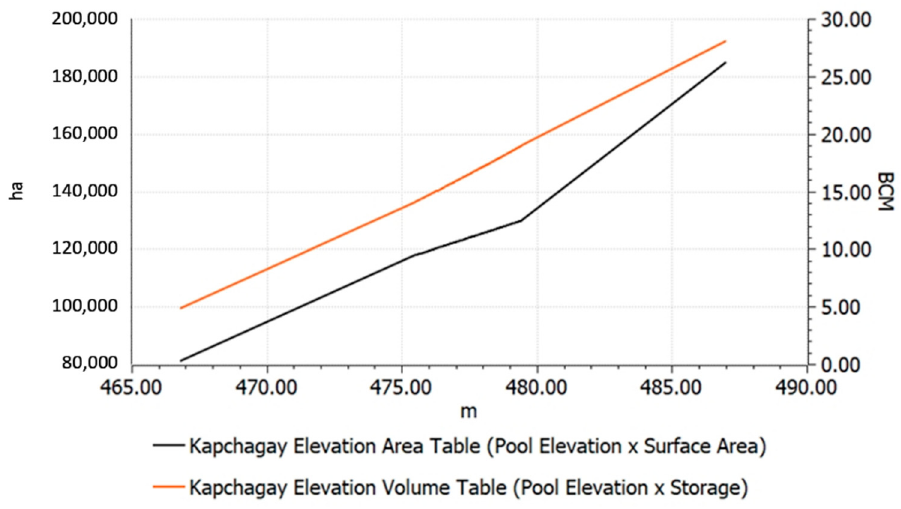
Figure A1. Elevation-Volume-Area data for the Kapchagay reservoir.